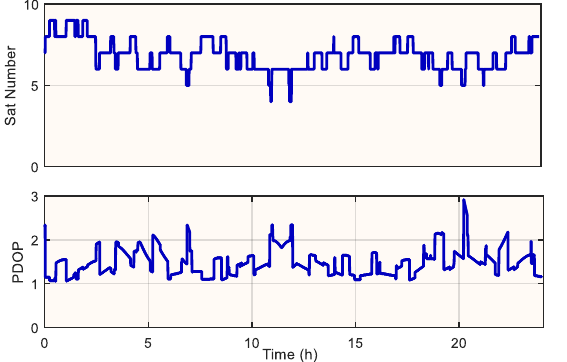
Figure 5. Number of available satellites and PDOP value of METG–MET3 (3 km) baseline in DOY218 for BDS-3.